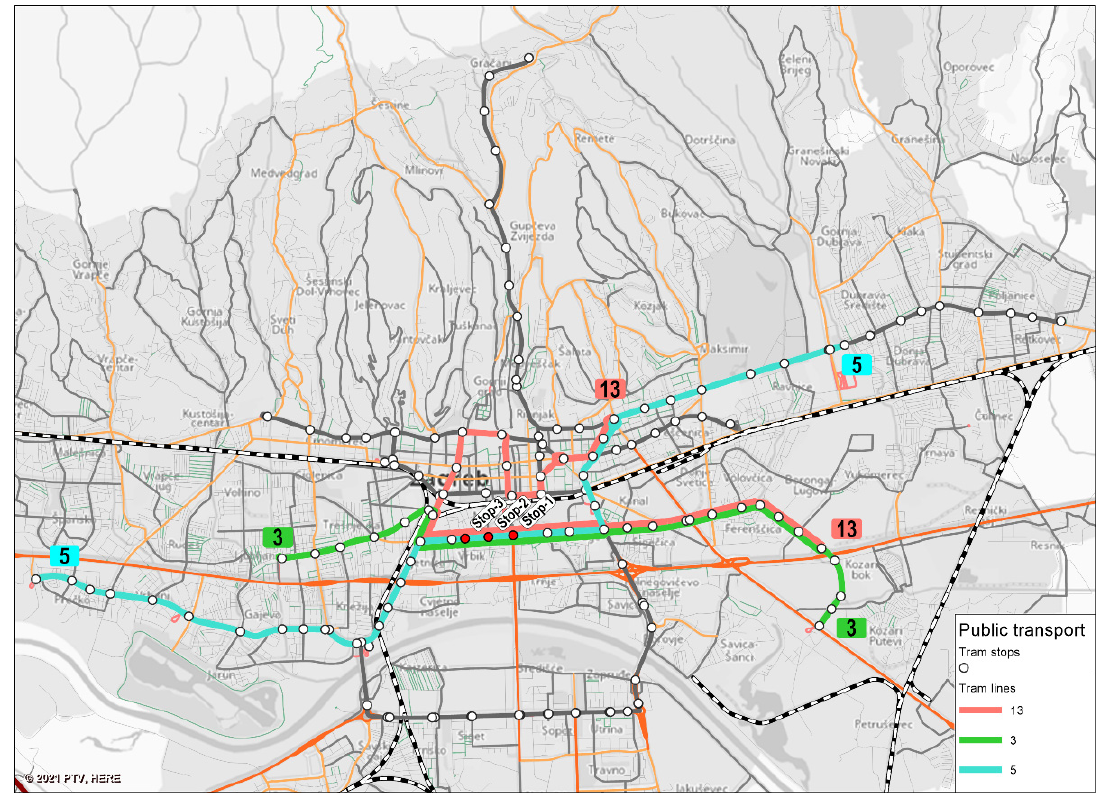
Figure 2. Investigation locations: positions of Stop-1, Stop-2, and Stop-3. Table 4. The indicators for tram lines 3, 5, and 13 on a characteristic working day during autumn, winter, and spring months.